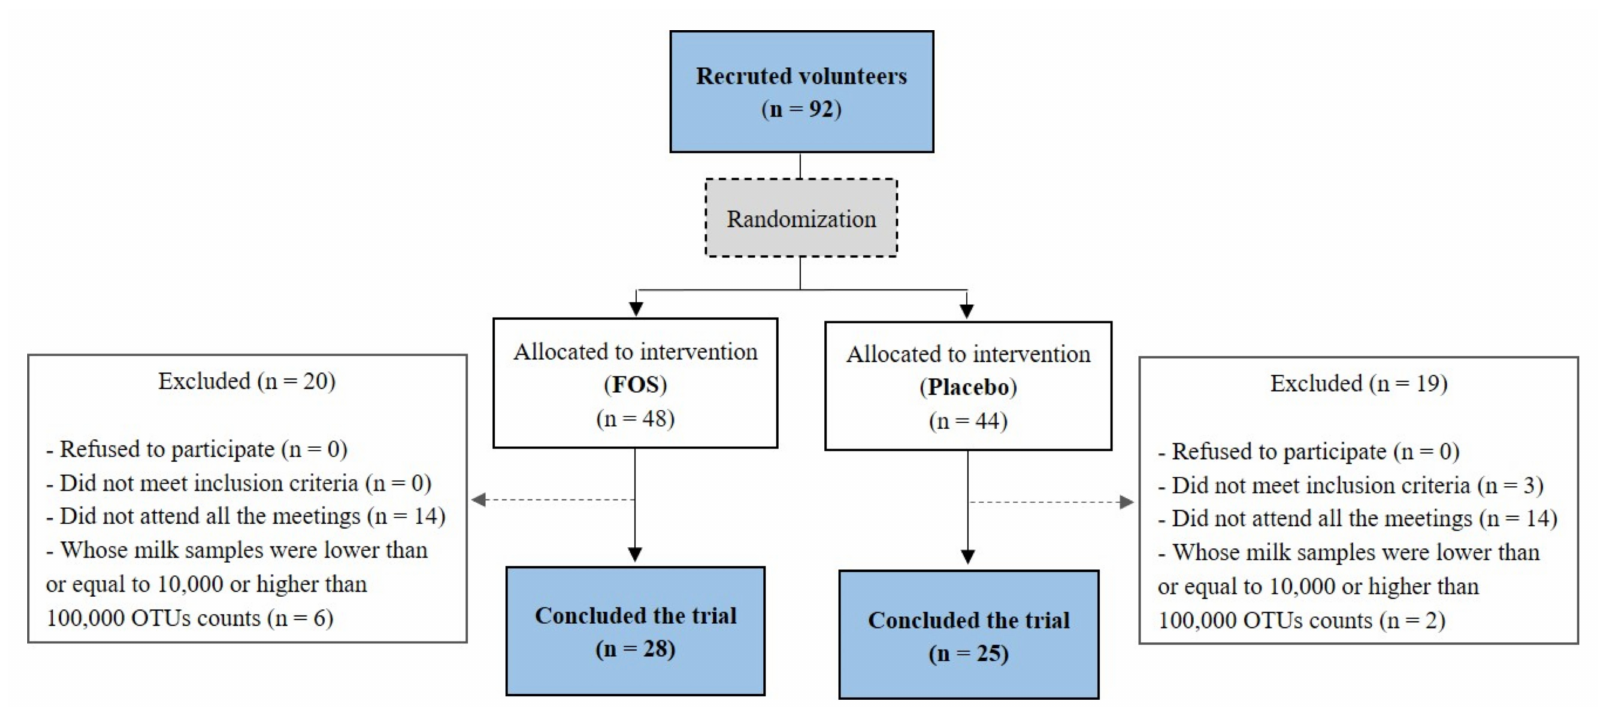
Figure 1. Flow diagram of participant recruitment followed for the study. FOS: Fructooligosaccharide; OTU: Operational Taxonomic Unit. The limits values of 10,000 and 100,000 were chosen arbitrarily based on the graph of OTU counts per sample in order to exclude